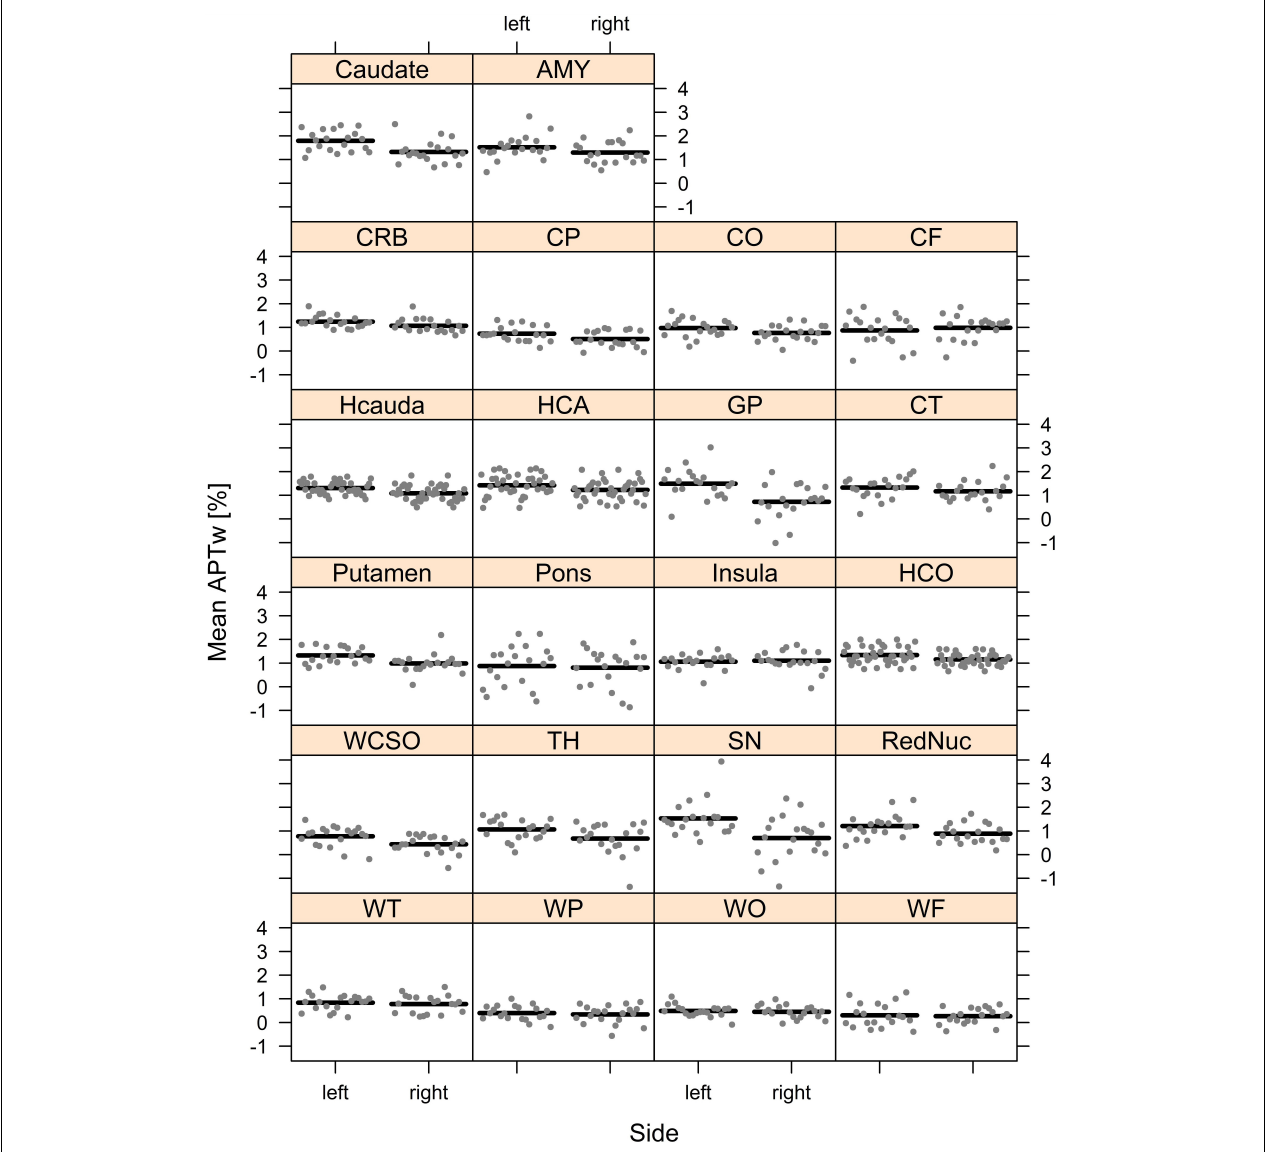
FIGURE 5 | Mean APTw intensity values for all brain regions (sides separated) are